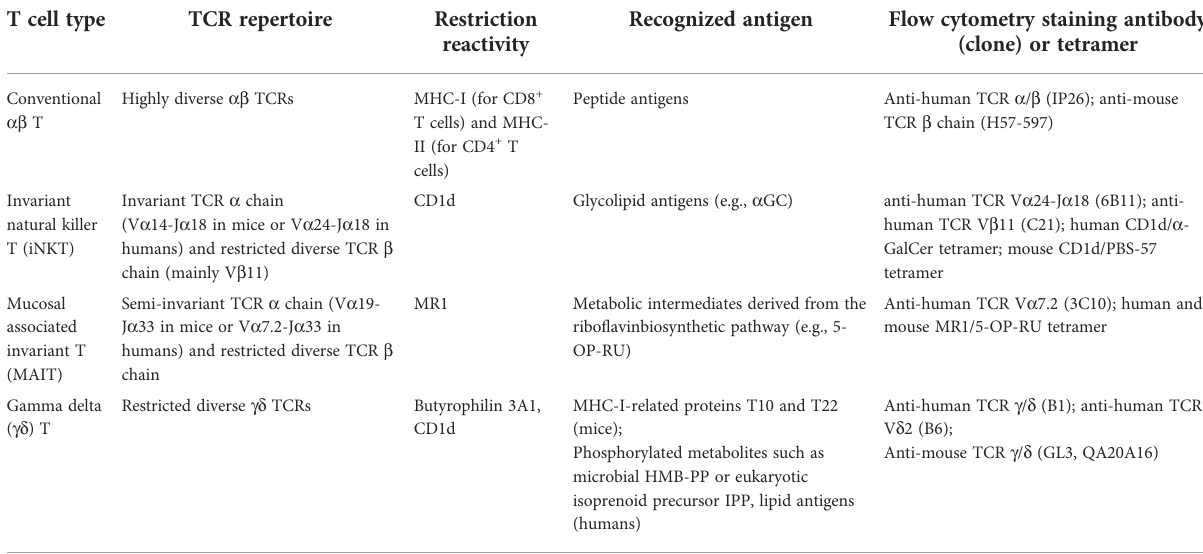
TABLE 1 TCR Comparison Between Different T Cell